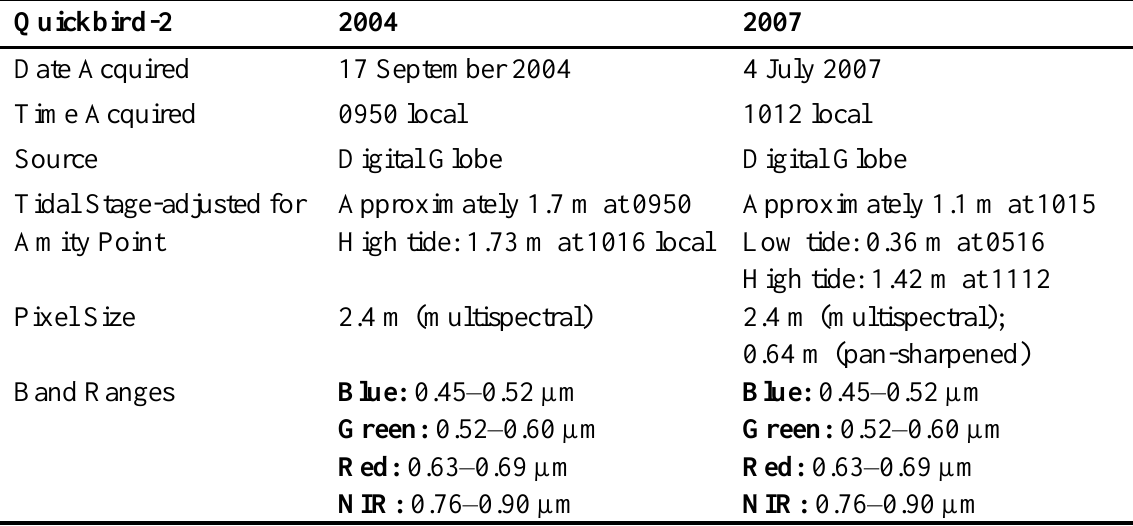
Table 1 . Detailed information for the 2004 and 2007 Quickbird image data sets including tidal stage. Brisbane Bar tide information was converted using the Amity Point offset from the NTT semidiurnal tidal plane and the tidal stage was estimated using the NTT standard tidal curve, at a tidal range of 1.0